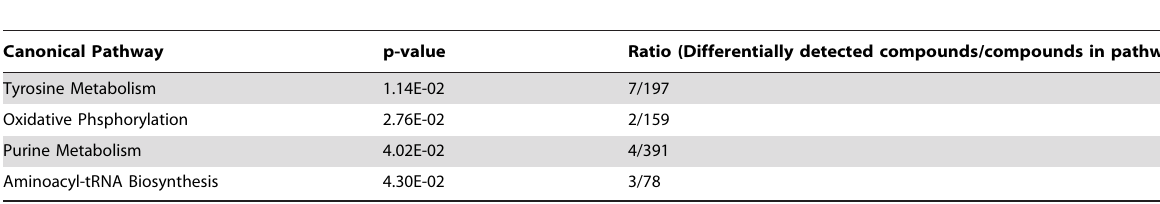
Table 1. Metabolic pathways significantly different in the urine of mutant mice.